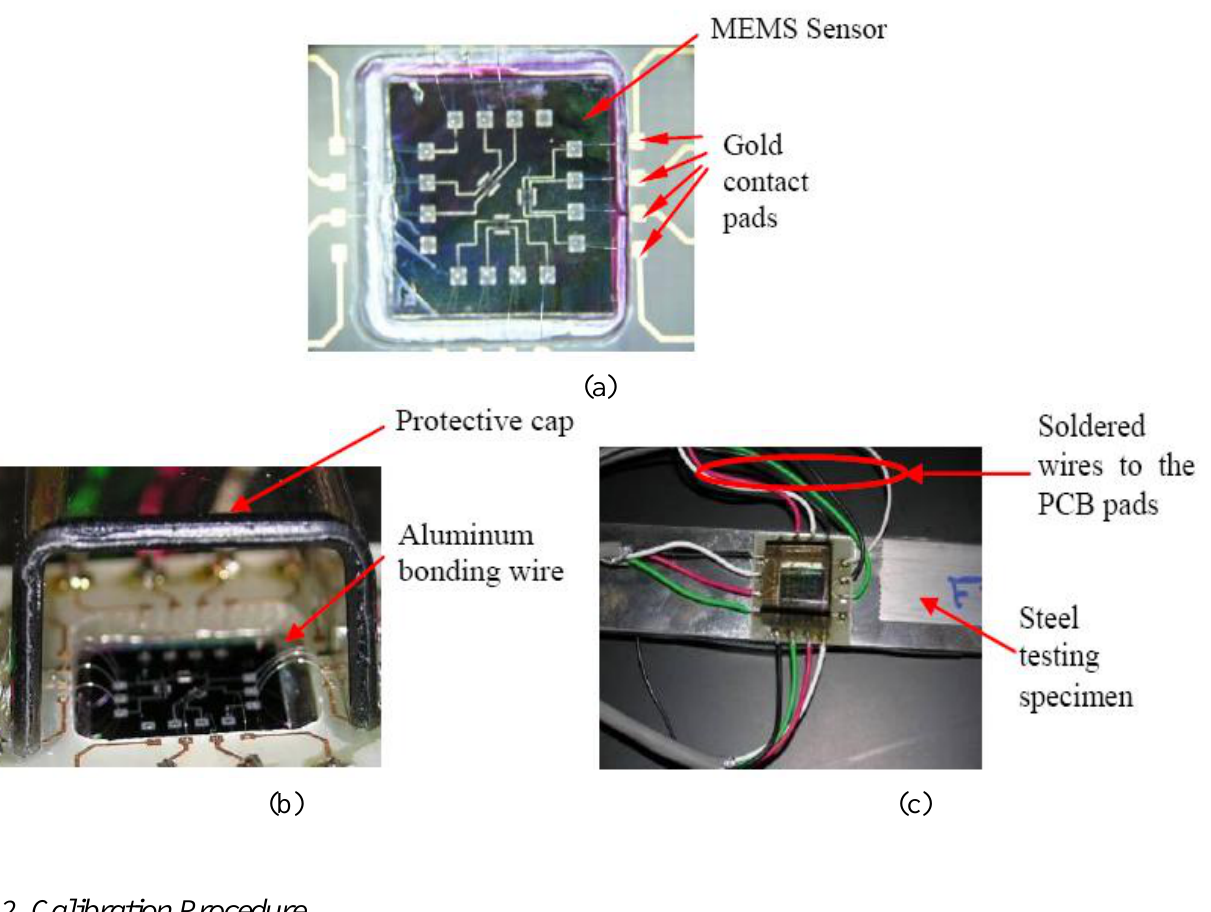
Figure 12. Prepared testing specimen; (a) after wire bonding, (b) after placing the polymeric protective cap and (c) top view of the wired